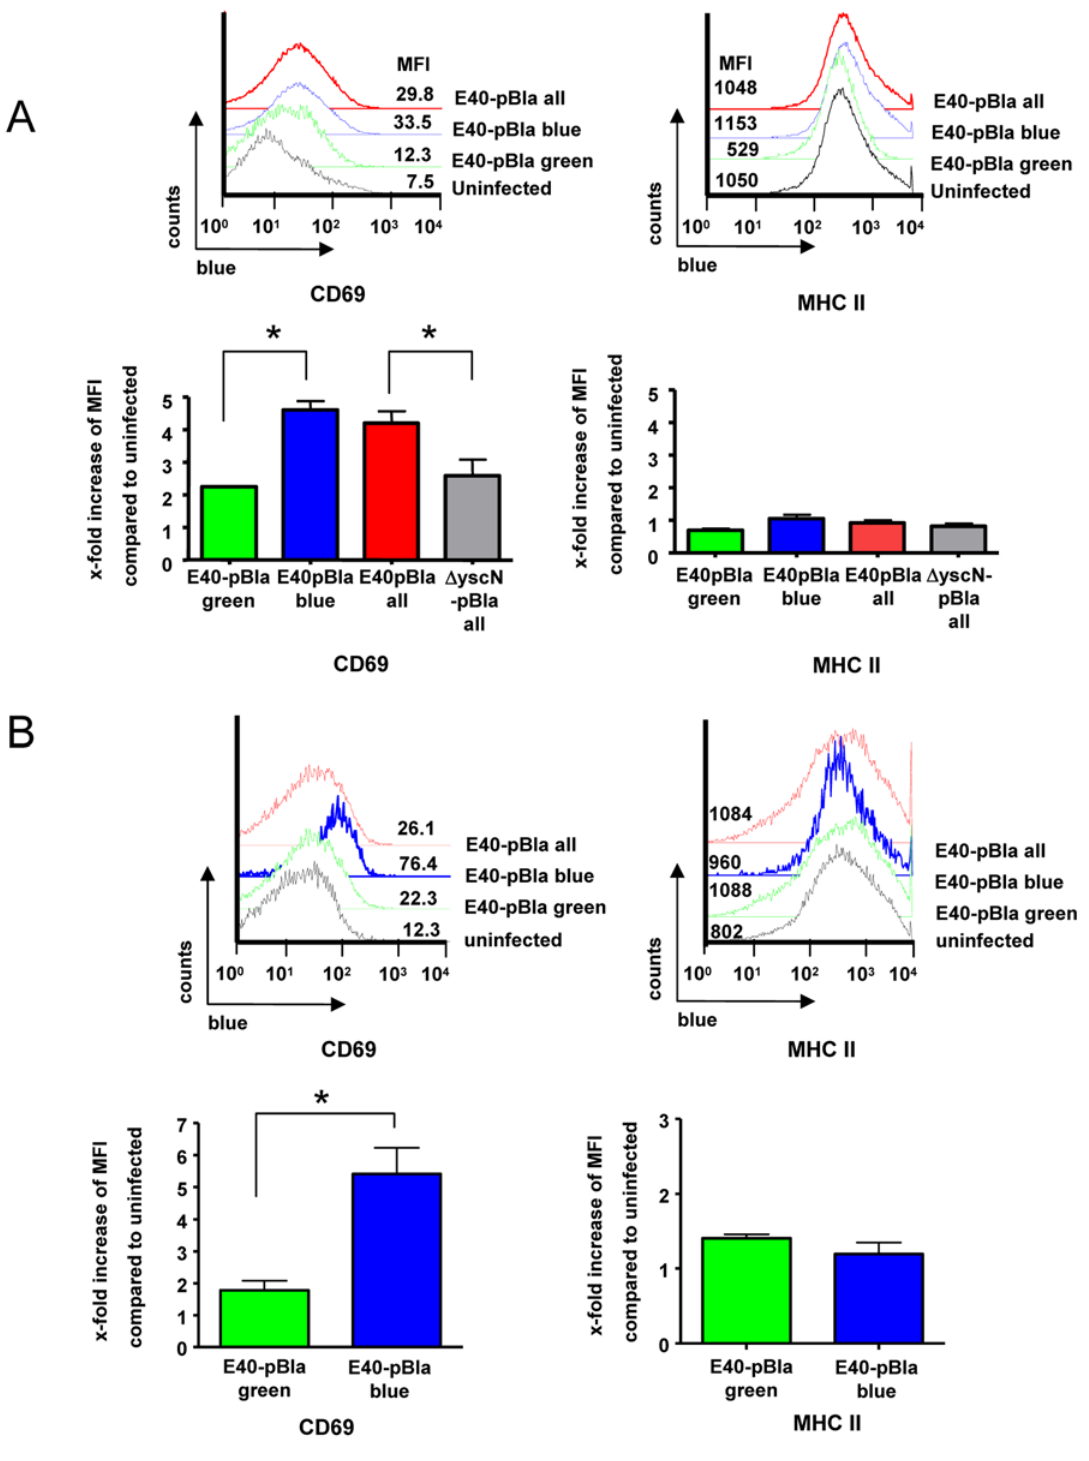
Figure 7. Changes of CD69 expression in splenocyte populations after Yersinia infection. (A) Cultured splenocytes were infected with E40- pBla (MOI 50) or mock-infected for 1 hour or (B) desferrioxamine conditioned C57BL/6 mice were left untreated or infected with 5 6 10 5 E40-pBla for two days and the splenocytes were then isolated. Splenocytes were stained with anti-CD19-APC, anti-CD69-PE-Cy7 and subsequently with CCF4 and analyzed by flow cytometry. Cells were gated (as shown in Figure S3) for high green fluorescence (viable cells) and B cells (CD19 + ). Left panels show histograms for CD69 expression of non-infected cells gated for viable CD19 + cells (black line) or of E40-pBla infected cells gated for all viable CD19 + cells (total, red line), gated for green + blue + CD19 + cells (blue line) or green + blue 2 CD19 + cells (green line). Mean fluorescence intensities (MFI) of CD69 expression are depicted for this representative experiment. Right panels show the means and SEM of the x-fold increase of MFI of the indicated cells compared to uninfected of (A) three independent experiments or (B) two independent experiments with a total of five mice per group. Asterisks indicate significant differences, p , 0.01.